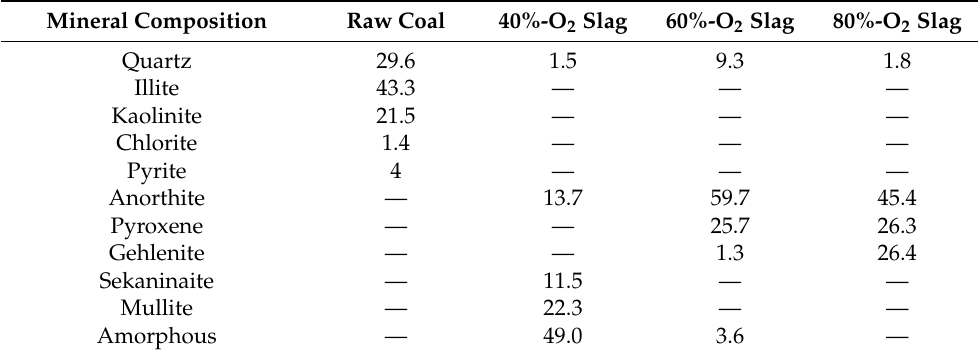
Table 6. Mineral composition of UCG slag by XRD analysis and Siroquant.